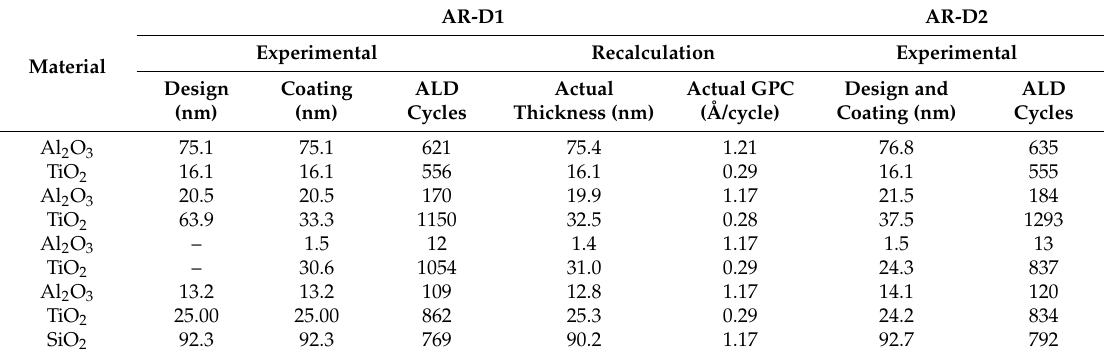
Table 3. Designed layer thickness and necessary ALD cycles of AR coating on fused silica. AR-D1 AR-D2 Experimental Recalculation Experimental Material Design Coating (nm)